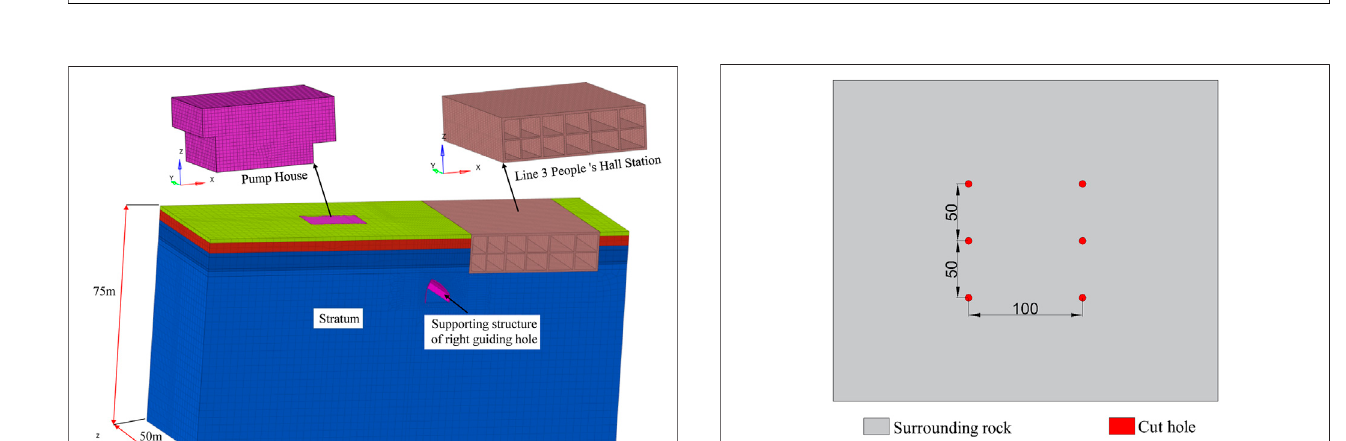
FIGURE 2 | Blasting hole layout of the station hall fl oor (unit: mm).